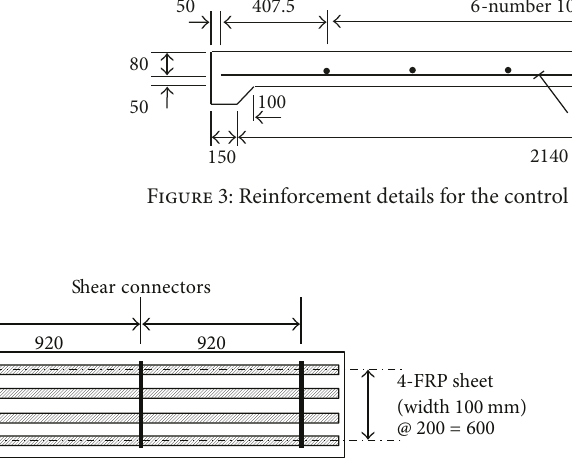
Figure 4: Locations of shear connector and CFRP sheets for the proposed retrofit